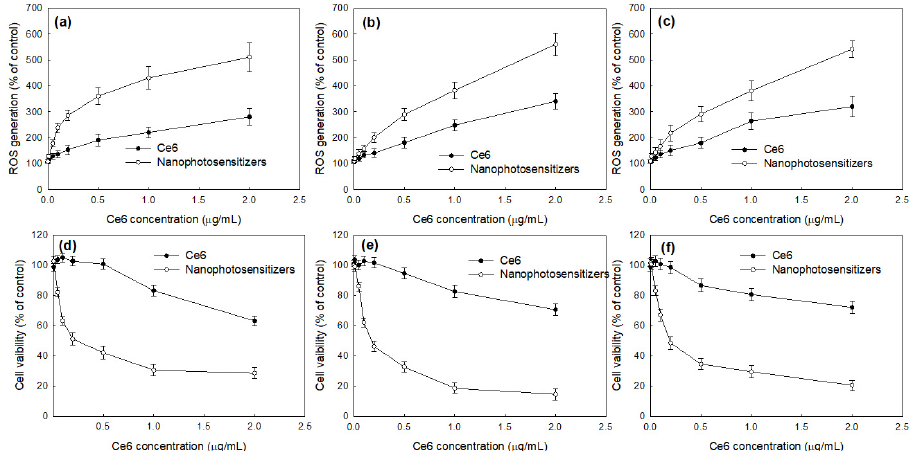
Figure 10. Relative ROS generation ( a – c ) and phototoxicity ( d – f ) by treatment of Ce6 or nanophotosensitizers. ( a , d ), YD-38 cells; ( b , e ), KB cells; ( c , f ) SCC-15 cells. The results are the average ± standard deviation (s.d.) from eight different